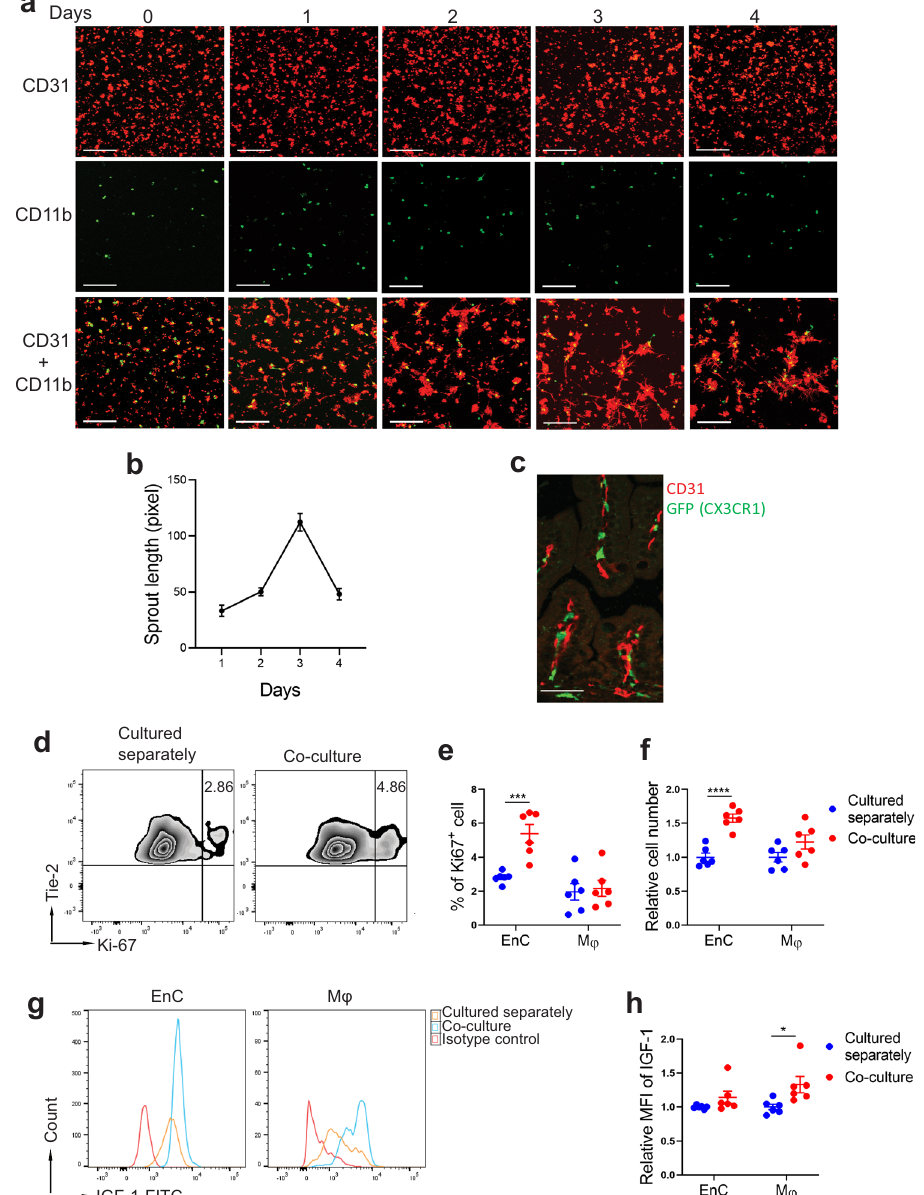
Fig. 3 Neonatal intestinal macrophages promote endothelial cell sprouting/proliferation in vitro via IGF-1. a 4 × 10 4 intestinal endothelial cells (from mT/mG mice — red) and 2 × 10 4 CD11b + intestinal myeloid cells (from CX3CR1-GFP mice — green) were cultured in duplicated wells separately or together in Matrigel and images were taken at day 1 – 4 of culture. scale bar: 100 μ m. b When CD31 and CD11b were cultured together, endothelial cell sprout length per area was assessed over time (mean ± SEM). For each time point, 7 – 10 sprouts per area were measured. Sprouts were unmeasurable in individually cultured cells. c Small intestinal tissue of a 24 h-old CX3CR1-GFP reporter neonatal dam-fed pup was stained for CD31 (red) and GFP (CX3CR1 -green). Scale bar = 100 μ m. d – h 5 × 10 4 intestinal CX3CR1 + macrophages and 10 × 10 4 endothelial cells cultured separately or together in 24-well plates were collected at 48 h of culture and stained with anti-Tie-2, CX3CR1, Ki-67, IGF-1 antibodies or isotype controls for fl ow cytometric analysis. d Contour plots showing the percentage of proliferating (Ki-67 + ) endothelial cells. e Percentage of proliferating (Ki-67 + ) endothelial cells (Tie-2 + CX3CR1 − and macrophages (Tie-2 − CX3CR1 + ). f Relative number of macrophages and endothelial cells in co-culture to their respective number when grown separately. g Histogram showing IGF-1 expression of neonatal intestinal endothelial cells and macrophages when cultured separately or together compared to isotype antibody control. h Mean fl uorescence intensity of IGF-1 of the two cell populations when cultured separately or together. Data indicate two separate experiments combined (mean ± SEM for e , f , h ), n = 6/group ( e , f , h ). See supplemental Fig. 3 for gating strategy for d and g . P values were calculated using multiple t tests ( e , f , h ). * p < 0.05, *** p < 0.001, **** p < 0.0001. Source data are provided as a Source Data fi loxP sites fl anking exon 4 of the Igf 1 gene, to generate mice with therefore macrophages (Supplementary Figure 3). Litters with IGF-1-de fi cient macrophages (Fig. 5a). We had con fi rmed that, in ~50% of the pups having IGF-1-de fi cient macrophages ( Igf1 f/ f Cx3cr1-Cre + / − , named Igf1 Δ M ϕ ), and 50% having IGF-1- the neonatal intestine, CX3CR1 + cells express CD11b, F4/80, CD64, but are negative for Ly6C, CD11c, and NK1.1 and are suf fi cient macrophages ( Igf1 f/f = controls) were generated.